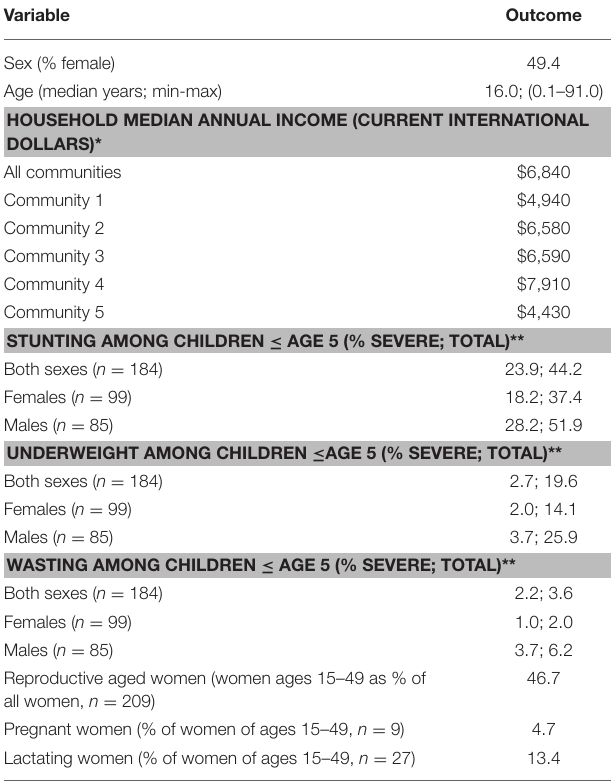
TABLE 1 | Subject population description of key variables and